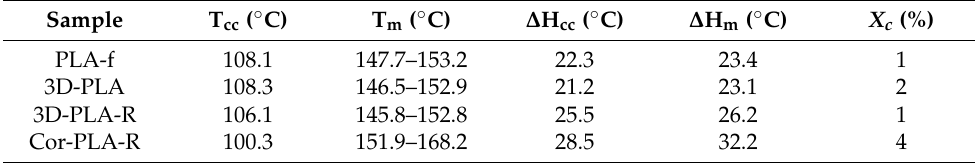
Table 3. DSC first heating scan results of the different samples.